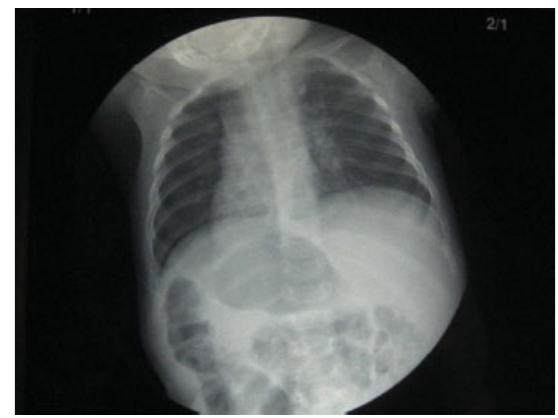
Fig. 2 Postoperative chest radiograph documenting